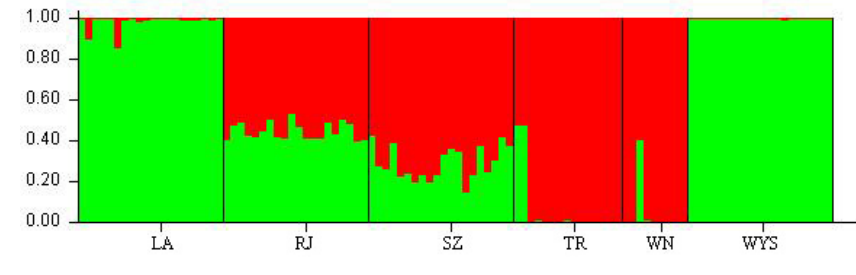
Figure 4. Population structure of six populations of C. tsoongiana prepared using the STRUCTURE program (Pritchard Lab, Stanford University, CA,